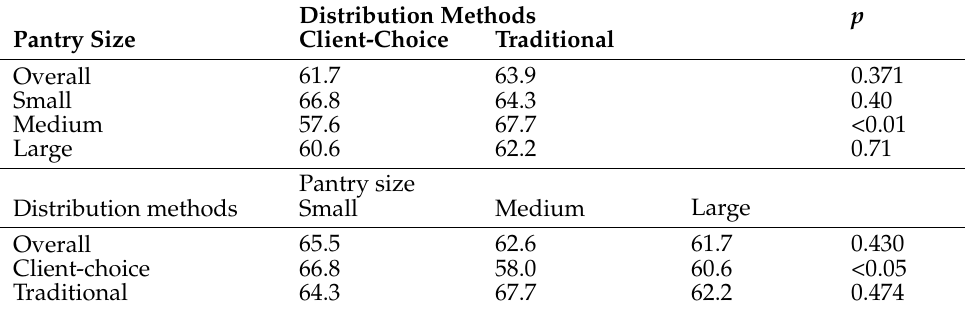
Table 3. FAST scores by food pantry size and distribution